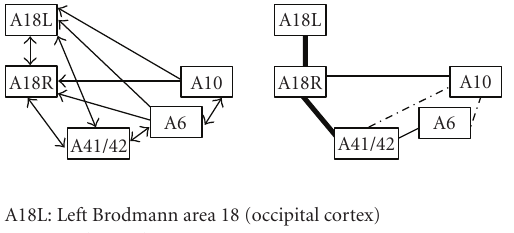
Figure 5: The network and results for McIntosh et al.